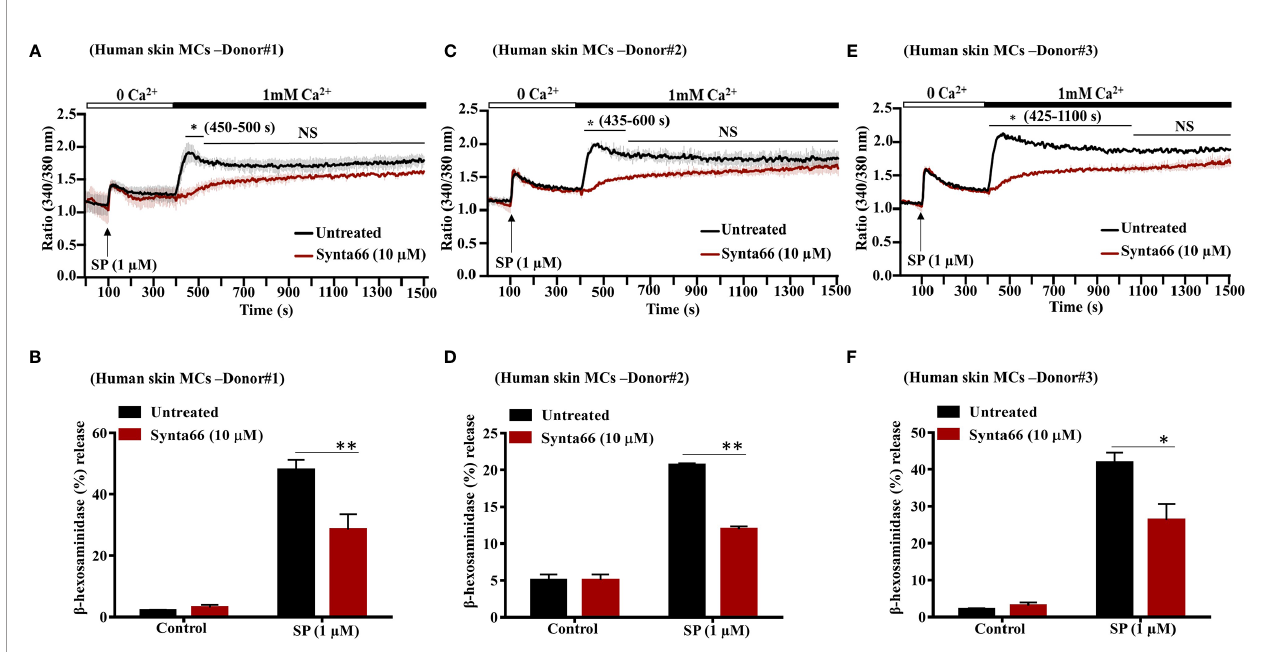
FIGURE 4 | Synta66 inhibits SP-induced Ca 2+ in fl ux and degranulation in Human Skin Derived MCs. (A, C, E) MCs from three donors were pretreated with Synta66 (10 µM, 30 min) and intracellular Ca 2+ in fl ux was determined in (B, D, F) . MCs were preincubated with Synta66, stimulated with SP (1 µM) and b -hexosaminidase release was determined. Data shown are mean ± SEM of three individual experiments from three donors. Statistical signi fi cance was determined by two-way ANOVA with Tukey ’ s multiple comparisons at a value **p < 0.01, *p < 0.05, and NS, “ not signi fi cant ”